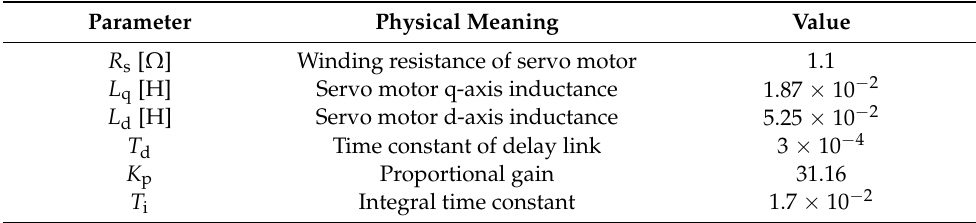
Table 1. Current loop simulation model parameters. Parameter Physical Meaning